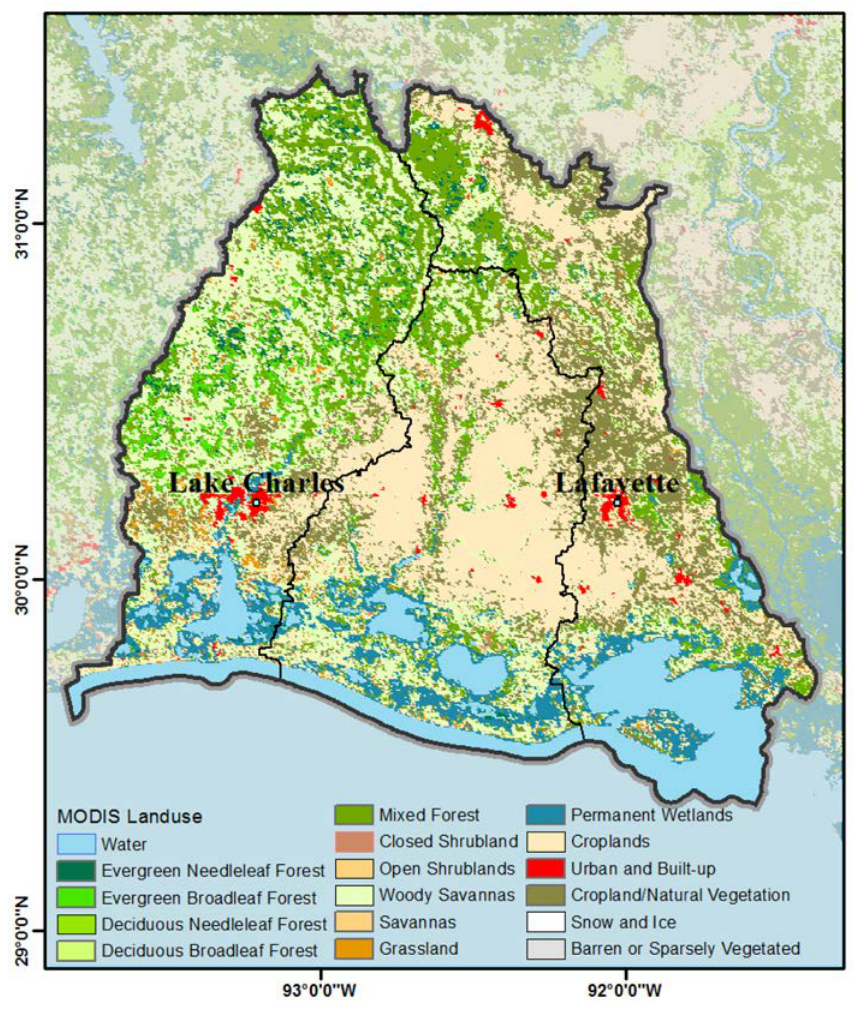
Figure 2. Land cover information of the study region (data source: MODIS